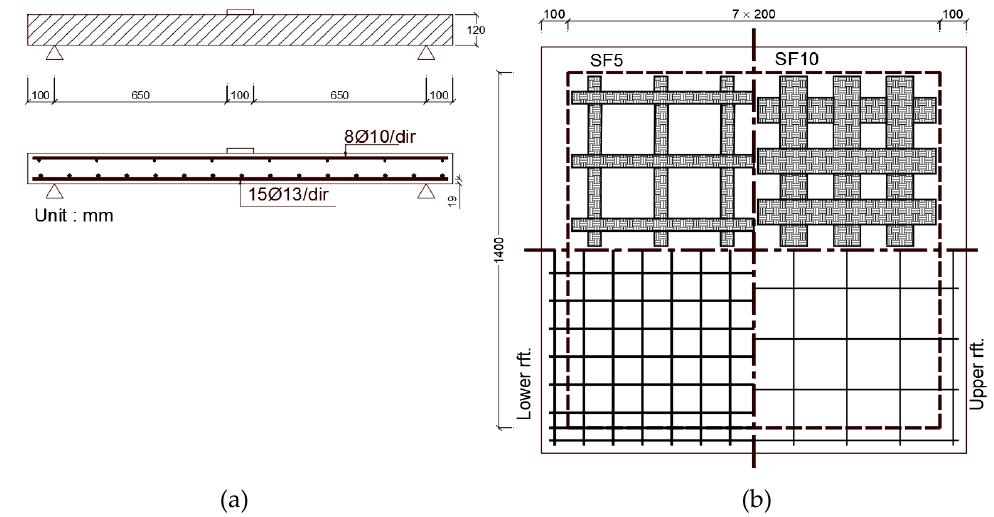
Figure 7. CFRP strips with different widths applied to the tension side of the slab, ( a ) two-way specimen cross section, ( b ) top and bottom reinforcement and two CFRP strip widths tested [33].